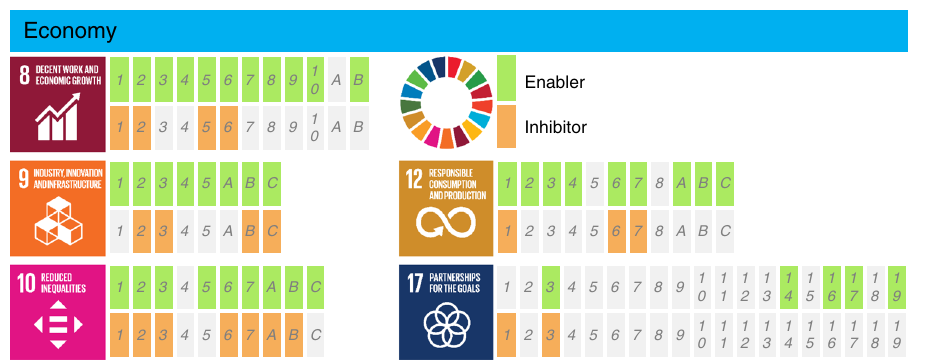
Fig. 3 Detailed assessment of the impact of AI on the SDGs within the Economy group. Documented evidence of positive or negative impact of AI on the achievement of each of the targets from SDGs 8, 9, 10, 12, and 17 (https://www.un.org/sustainabledevelopment/). The interpretation of the blocks and colors is as in Fig. 2. (The content of of this fi gure has not been reviewed by the United Nations and does not re fl ect its views).